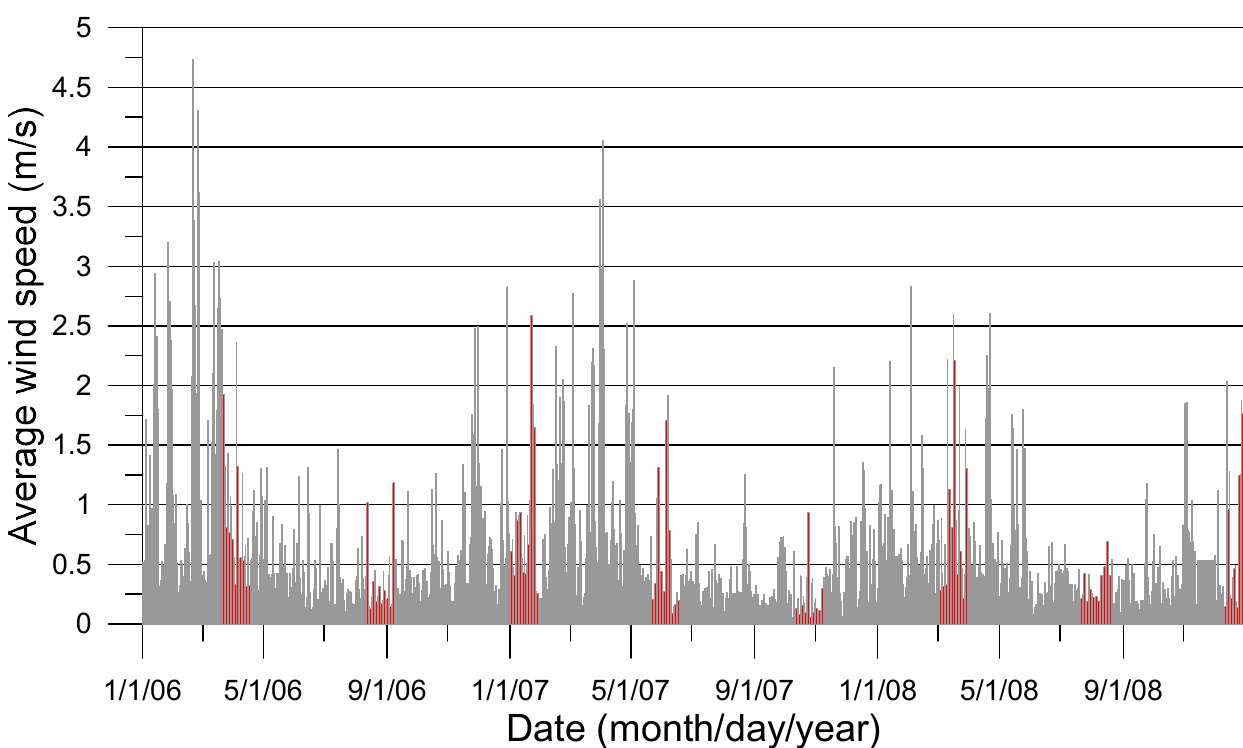
Figure A1. Average daily temperature at Newbury cutting.